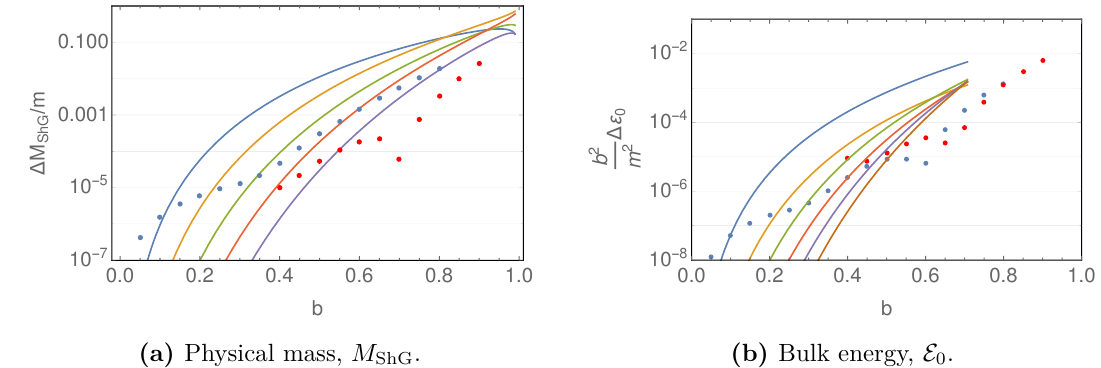
Figure 18. a) Presentation of M ShG as computed in section 6.5 (red dots) vs. its determination from extrapolated TSM data (blue dots). b) The same but for the bulk ground state energy density, E 0 . Solid curves shown are the same as in figure 11c-d. Results are presented as differences with the numerically exact TBA values.